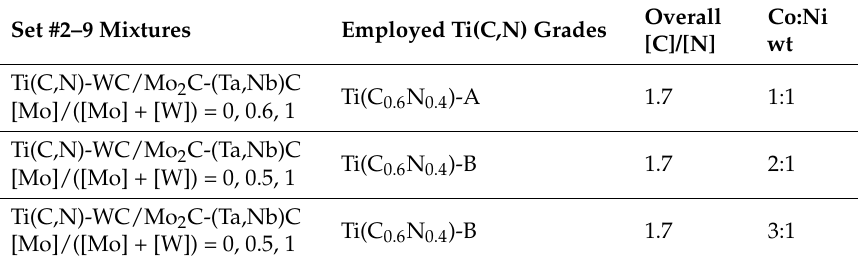
Table 2. Non pre-alloyed hard phases, varying Co:Ni and [Mo]/([Mo] + [W])